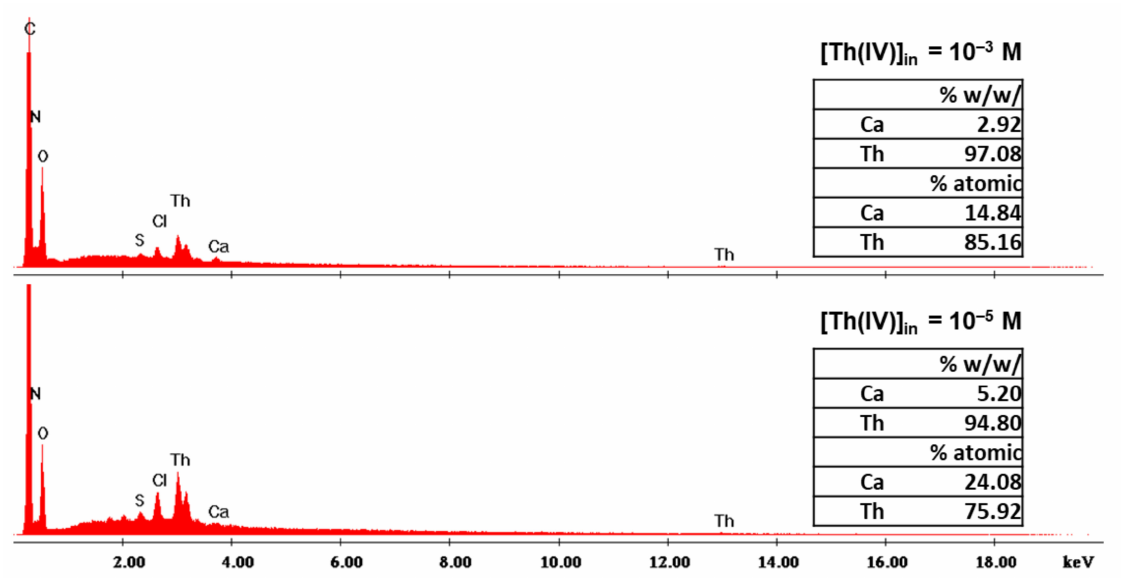
Figure 8. Energy-dispersive X-ray spectra (EDS) of dried X-alginate beads after sorption of different amounts of Th(IV) from solutions with different initial Th(IV) concentrations, as